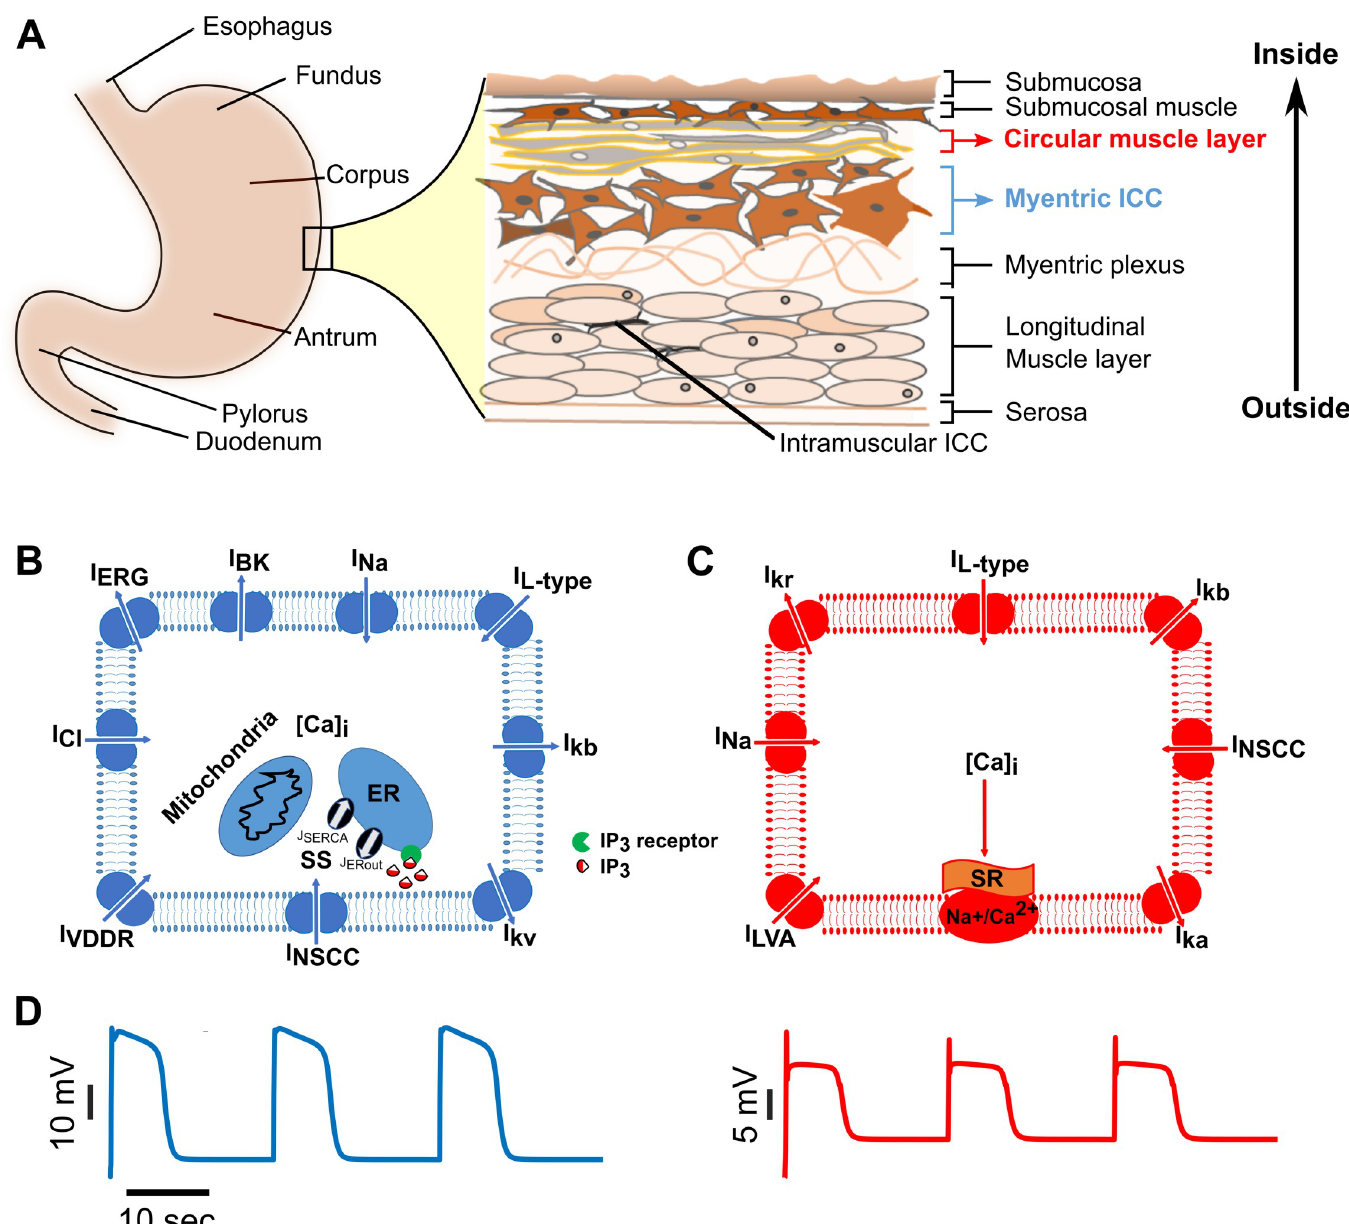
Fig 1. Biophysical models for ICCs and SM cells involved in gastric motility. Schematics showing (A) anatomical divisions of the stomach and the arrangement of various cell types in the stomach wall, (B) membrane ionic currents and intracellular Ca 2+ -IP 3 components included in an interstitial cell of Cajal (ICC) model, and (C) membrane ionic currents in a smooth muscle (SM) cell model. See Table 1 for symbols and details of ionic currents. [Ca] i = Intracellular Ca 2+ , ER = endoplasmic reticulum, Na + /Ca 2+ = Sodium/Calcium exchange pump, SR = Sarcoplasmic reticulum, SS = Submembrane space, (D) Simulated rhythmic membrane potential dynamics in an ICC (left panel) and an SM cell (right panel),